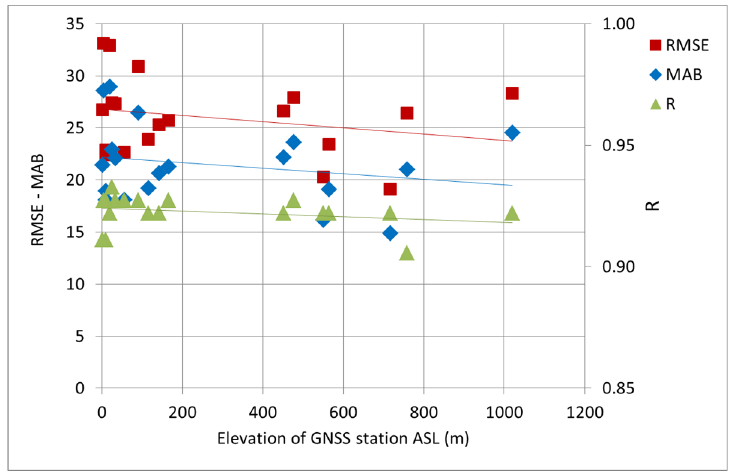
Figure 9. Plots of: RMSE vs. horizontal distances between WRF grid point and GNSS station ( a ); MB vs. GNSS station elevation h ( b ).